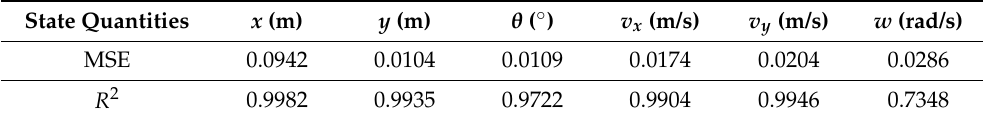
Table 3. Prediction accuracy results for variable driving force